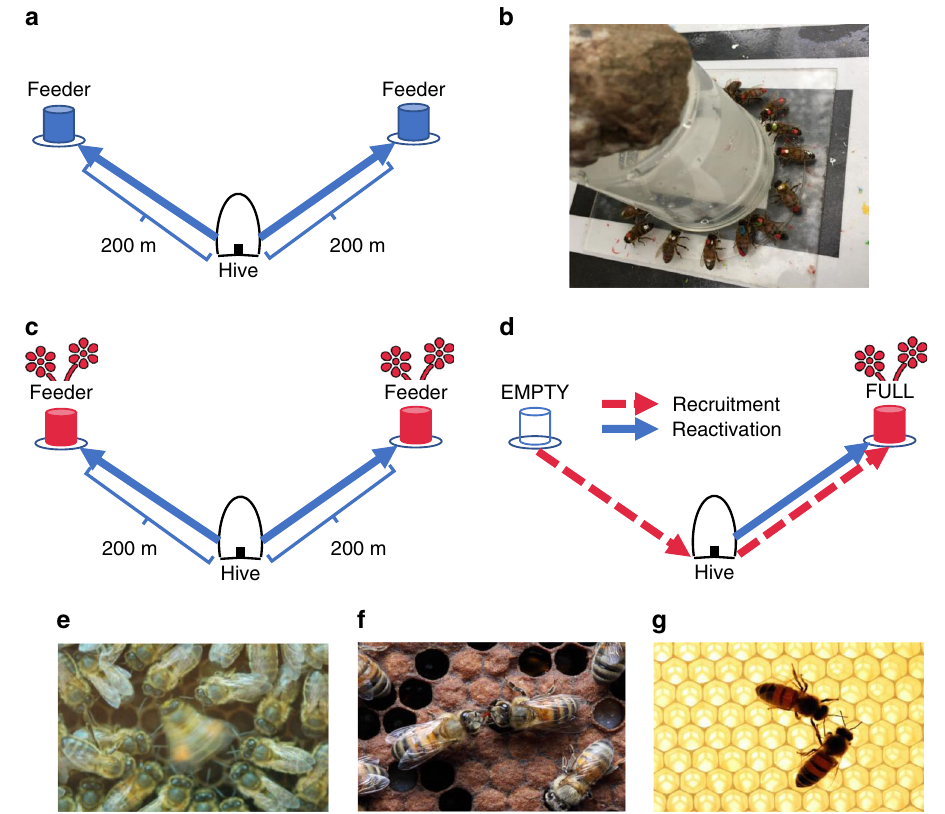
Fig. 1 Experimental design. a For each trial, 18 – 30 foragers from a single colony were trained to a feeder that provided unscented sucrose solution. The feeder was gradually moved to a location 200 m from the hive. A second group from the same colony was simultaneously trained to an identical feeder, with an angular separation of ~110 o , using the same methods. b Each forager was given an individually speci fi c enamel paint marking upon its fi rst arrival at a feeder. c On the morning before the trial, both feeders provided 2 M sucrose solution identically scented with an essential oil for 1 h (indicated in red), thereby allowing individuals to associate the provided scent with their foraging site. d During the trial, the FULL feeder provided 2 M sucrose solution identically scented as the previous morning, whereas the EMPTY feeder was left un fi lled. Bees in the FULL group could be reactivated to their familiar FULL feeder (reactivation NBDA; indicated by the solid blue line), whereas bees in the EMPTY group, upon discovering that their familiar feeder was now empty, became available for recruitment to the FULL feeder (recruitment NBDA; indicated by the dashed red line); see Supplementary Note 1 for an NBDA of the EMPTY group being reactivated to the EMPTY feeder. We recorded the order of both reactivation events and recruitment events within the same trial. Social networks were constructed that quanti fi ed bouts of dance-following ( e ), trophallaxis ( f ) and antennation ( g ) between marked individuals and foragers returning from the FULL feeder. Image e: taken by Christoph Grüter, used by permission. Images f and g: © Alexander Wild, used by permission.